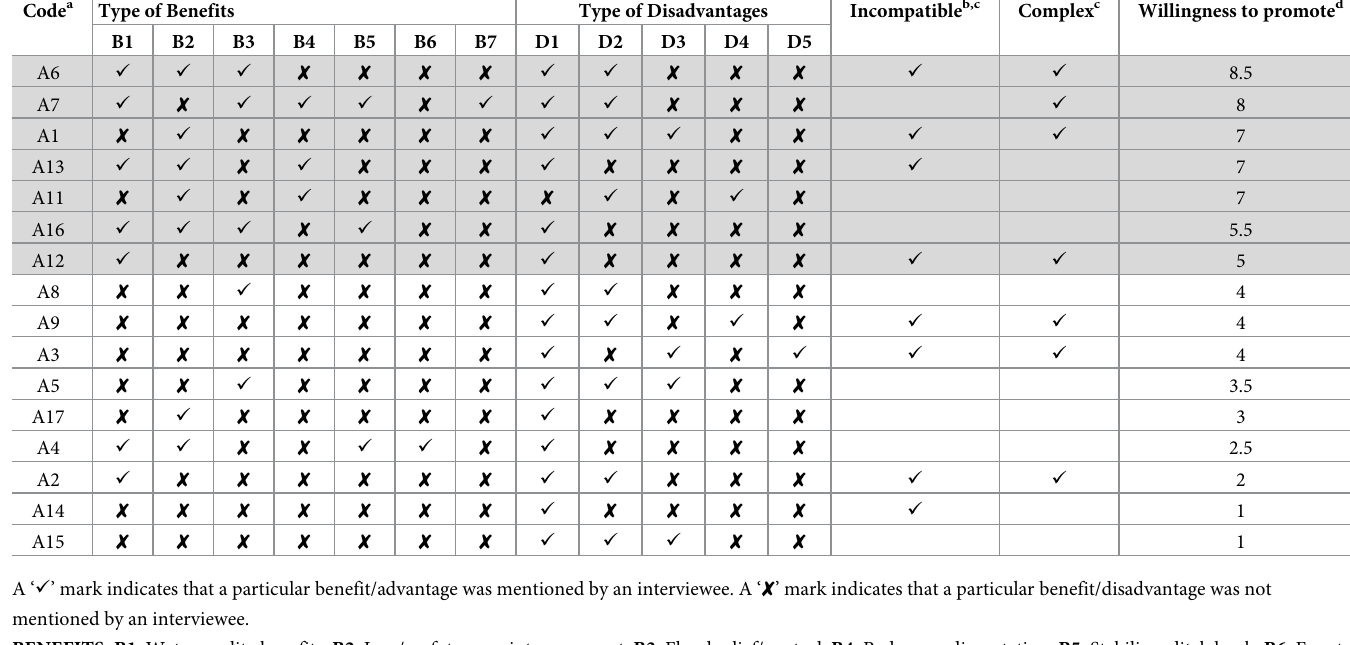
Table 6. Perceived attributes & willingness to promote two-stage ditches. Code a Type of